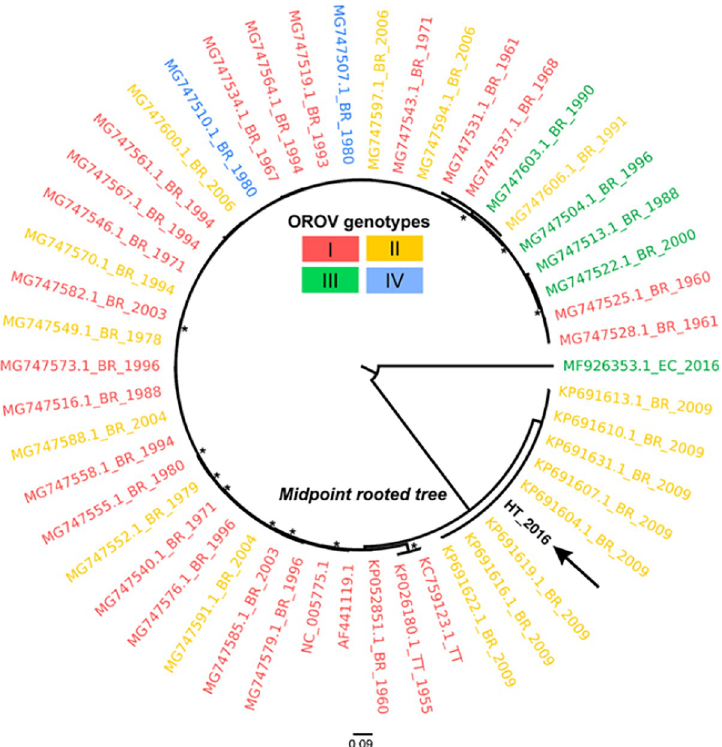
Fig 8. Maximum likelihood (ML) midpoint rooted tree based on 50 representative Medium segment sequences (4357 sites) of different OROV strains. Tips are colored according to genotype. The OROV sequence of this study (GenBank no. MN264268) is represented by the arrow and bolded name. Tip labels represents GenBank accession code, country of origin (BR, Brazil; PE, Peru; EC, Ecuador; HT, Haiti; TT, Trinidad and Tobago), and year of isolation. Asterisks indicate SH-aLTR/aBayes/ultrafast bootstrap support values. Only values equal or greater than 75% are shown. Branch lengths are drawn in scale of nucleotide substitutions per site according to the bar in the figure.